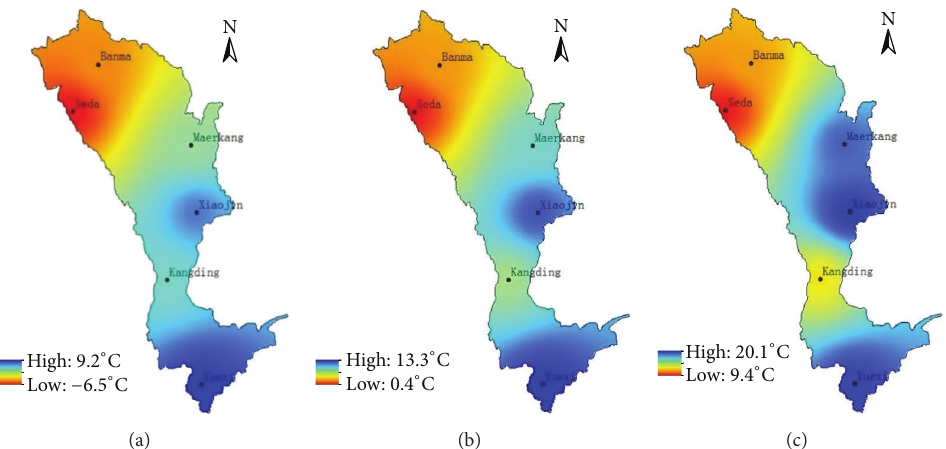
Figure 2: Spatial distribution of annual average temperature in the study area. (a) Minimum. (b) Mean. (c) Maximum.